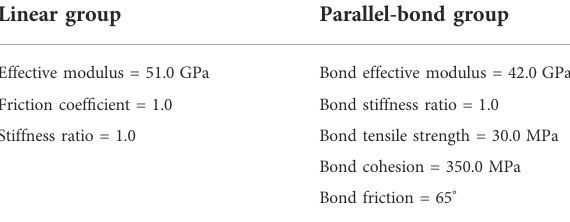
TABLE 1 Microscopic parameters of sandstone (Yuan et al., 2018).